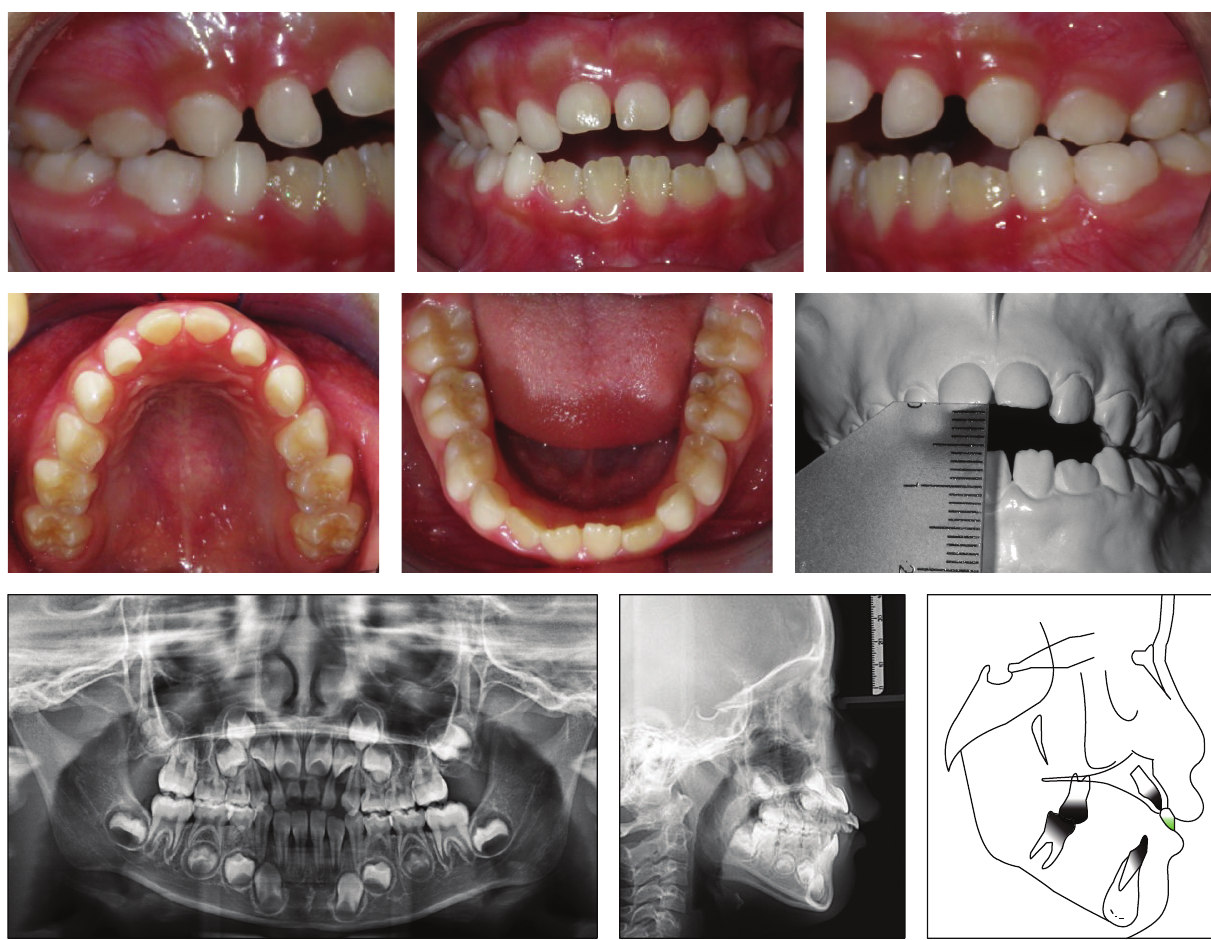
Figure 1: Pretreatment intraoral photographs, radiographs, and cephalometric